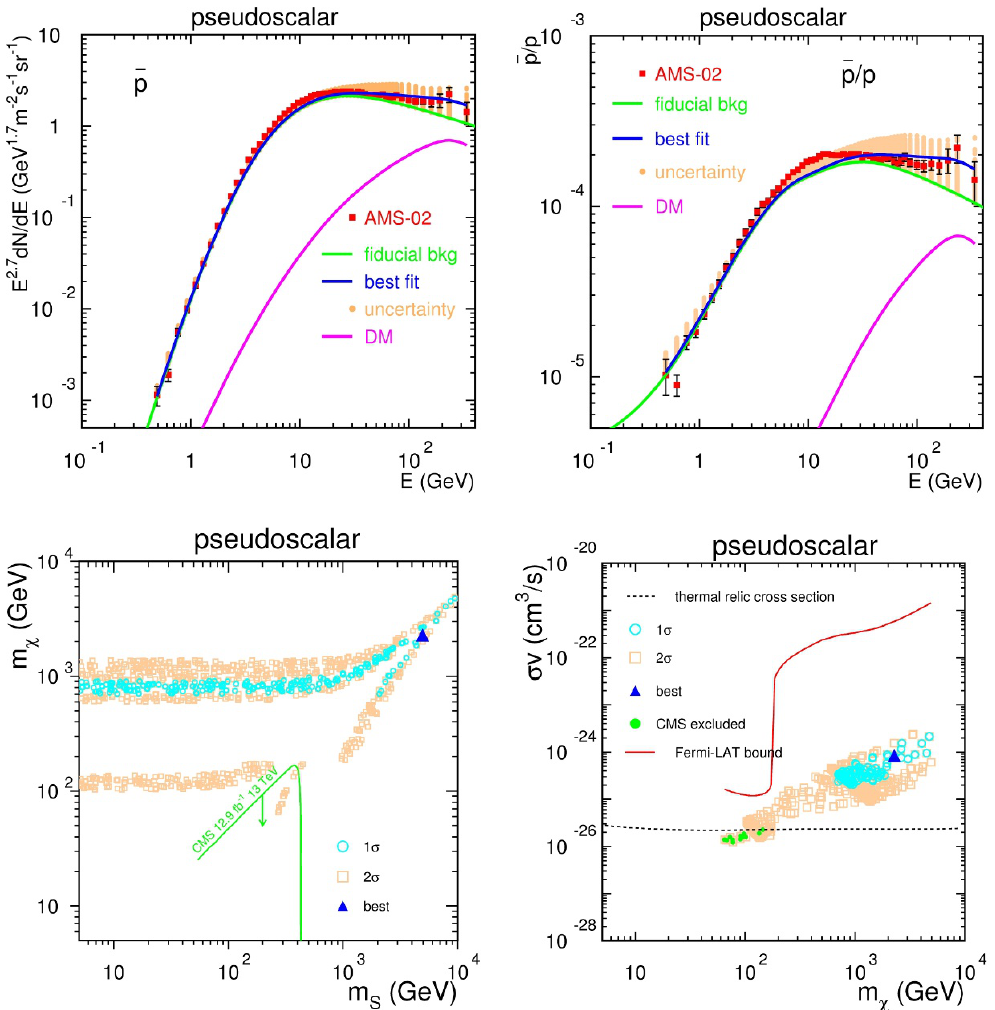
Figure 7 . Antiproton (cid:13)ux (top left), antiproton-to-proton ratio (top right), the AMS-02 favored region of masses (bottom left) and annihilation cross section (bottom right) in the pseudoscalar mediator model with the truncated Isothermal